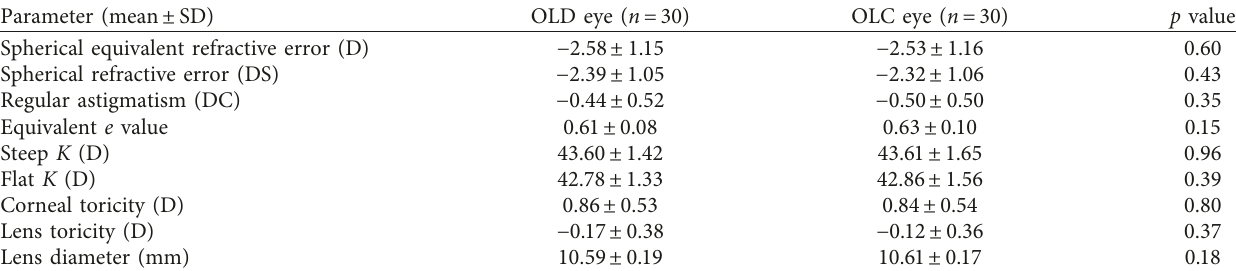
Table 1: Difference of biological parameters and lens between OLD eyes and OLC